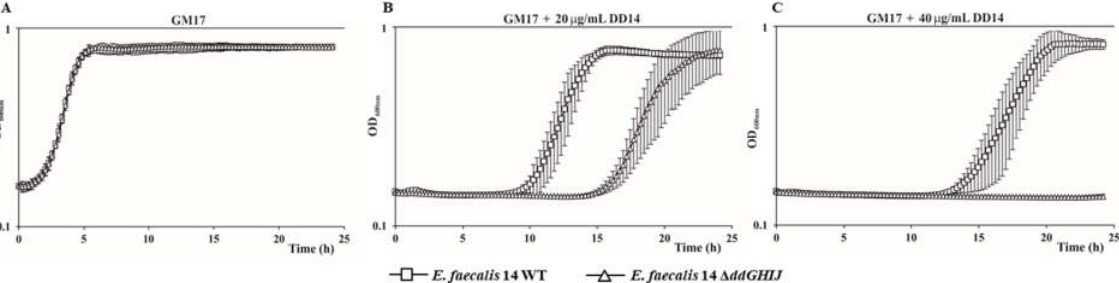
Figure 4. Growth curves of Enterococcus faecalis 14 and its Δ ddGHIJ mutant strain in GM17 broth ( A ) and in the presence of EntDD14 at 20 µg/mL ( B ) and 40 µg/mL ( C ).